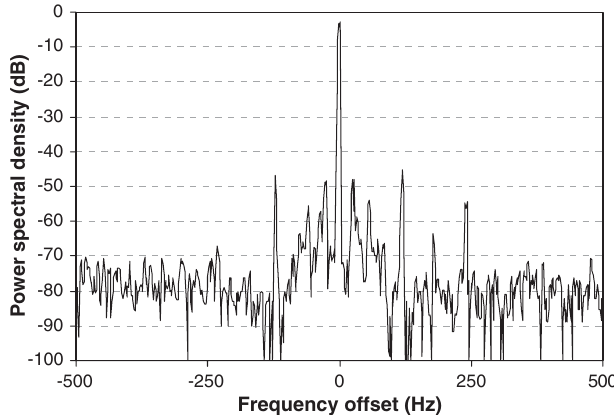
FIG. 6. Cavity spectral output (dB) with injection locked mag- netron and DSP control, RBW ¼ 3 Hz